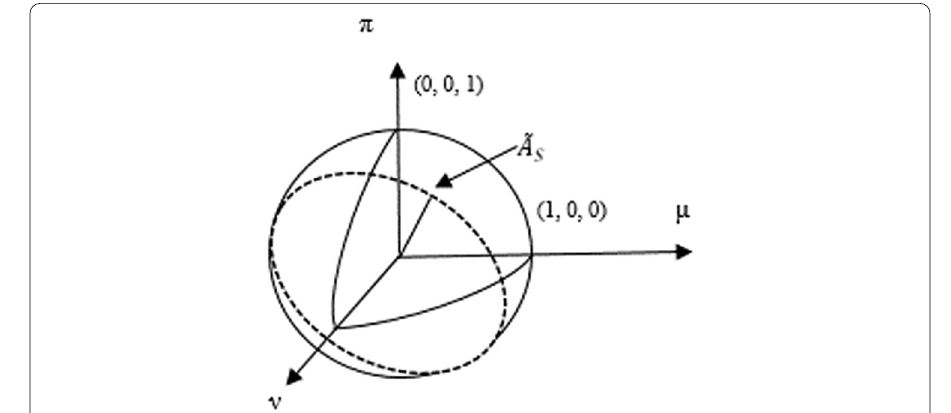
Fig. 1 Illustration of spherical fuzzy